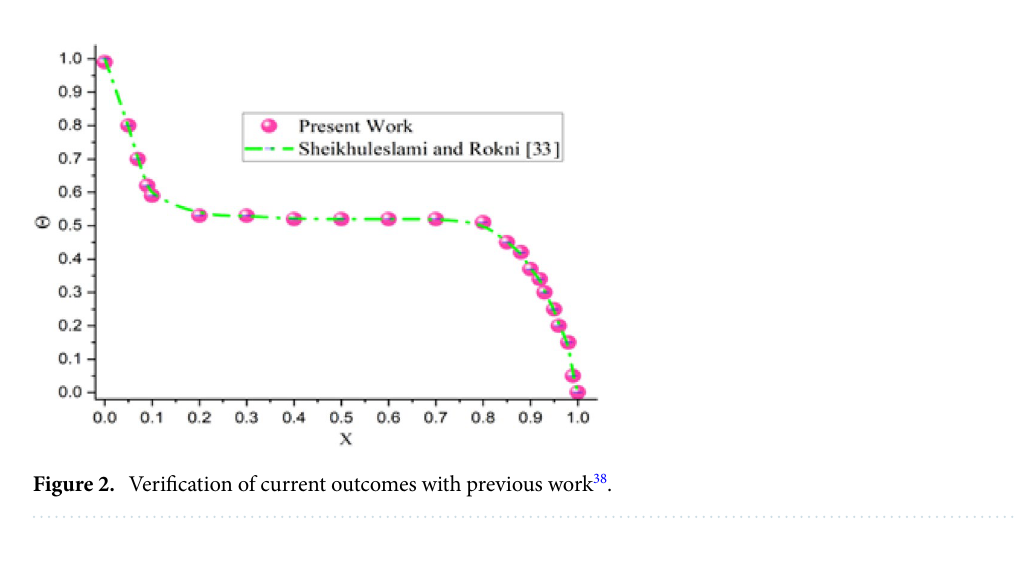
Figure 1. ( a ) Geometrical configuration and imposed boundary constraints using ( b ) A sampler triangular components and its associated volume control.